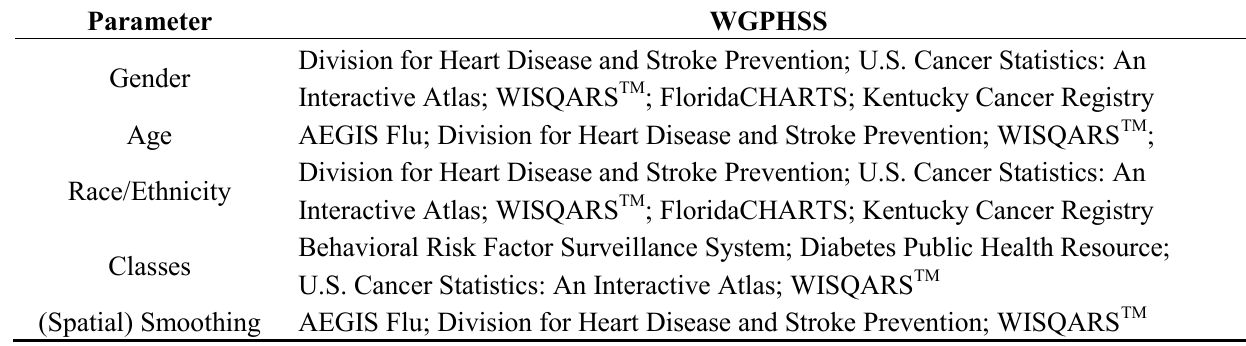
Table 4. WGPHSSs supporting customizing gender, age, race/ethnicity, classes, and (spatial)